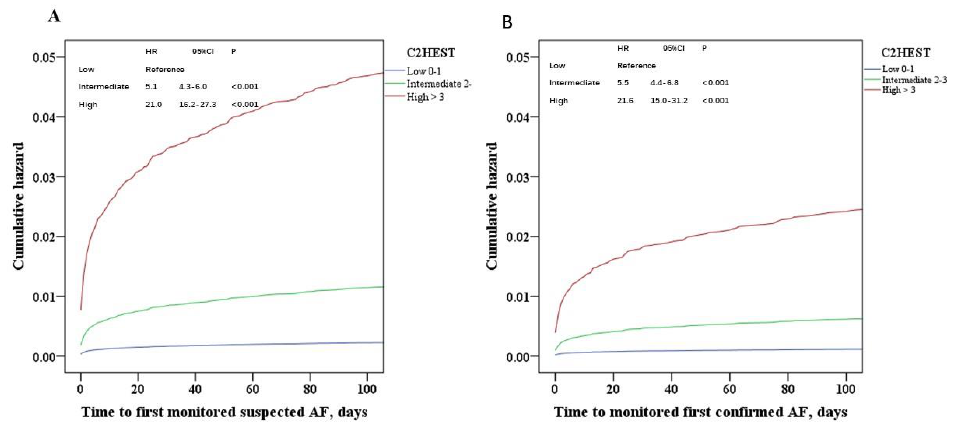
Figure 1. The cumulative risk of monitored AF, in relation to C 2 HEST. ( A ) Suspected AF, ( B ) Confirmed AF. * HR, hazard ratio. CI, confidential interval.